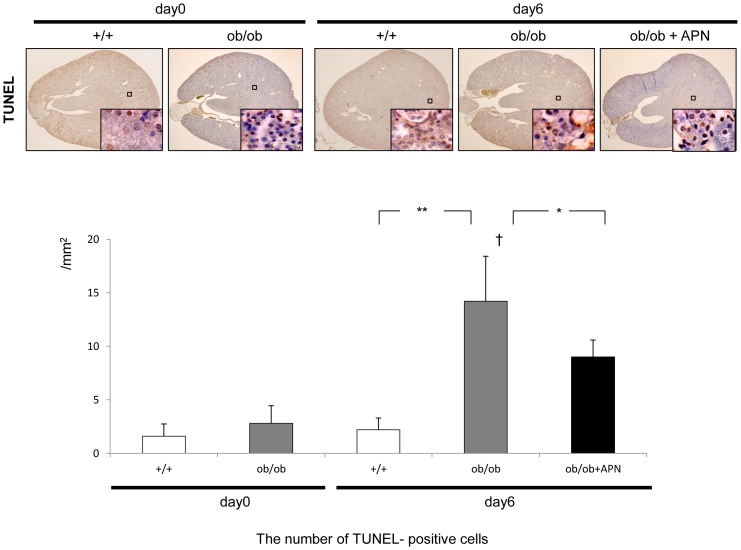
TUNEL staining and the number of TUNEL-positive cells.Data are indicated as the mean ± SD. *, p<0.05 between groups at the same time. **, p<0.01 between groups at the same time point. †, p<0.01 compared with the same group at day 6.